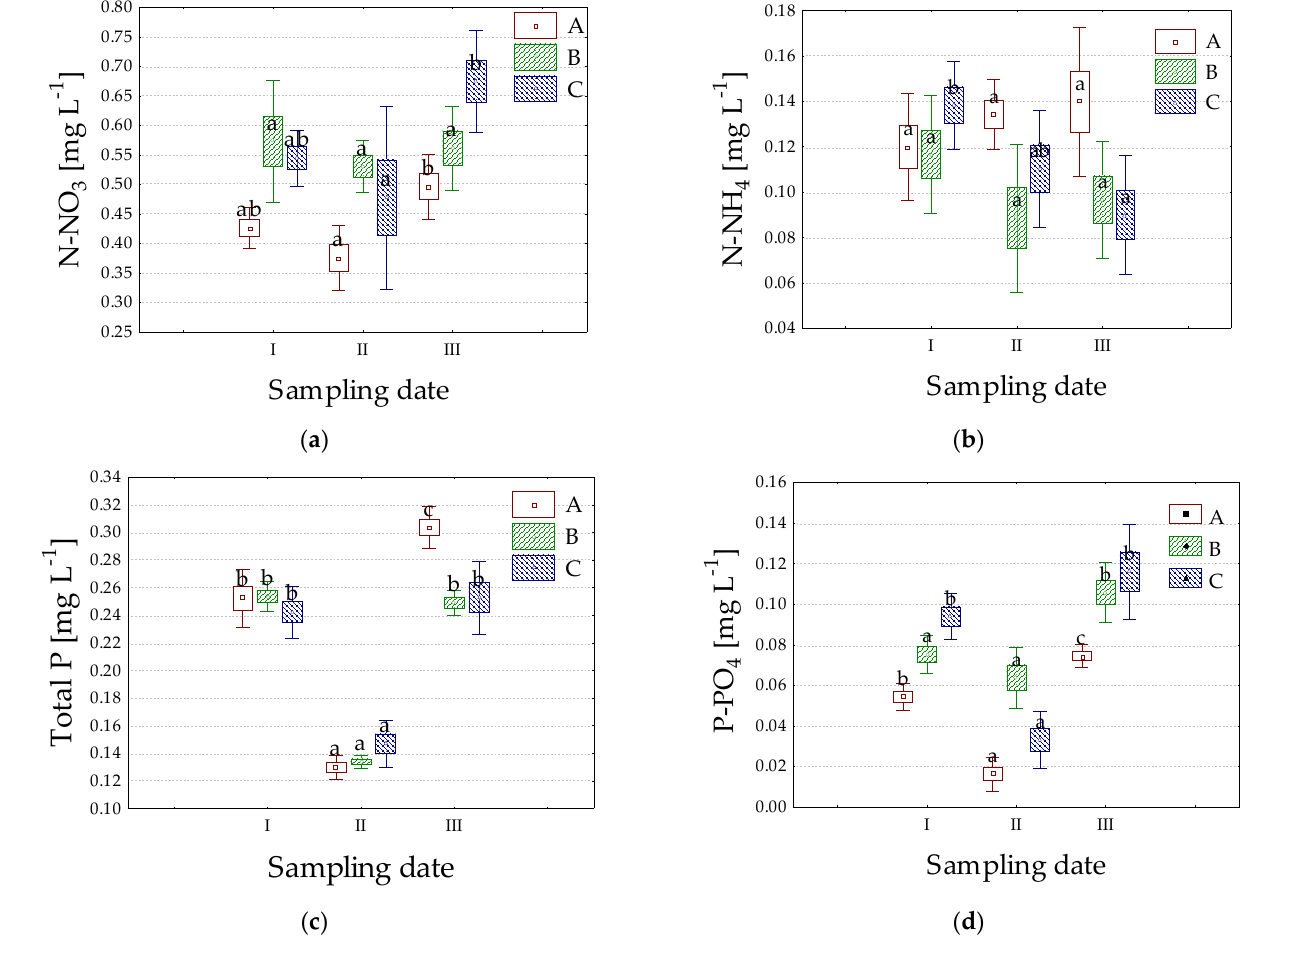
Figure 4. Changes in concentration of ( a ) NO 3 -N, ( b ) NH 4 -N, ( c ) total phosphorus, and ( d ) PO 4 -P in water samples in successive dates of sampling in three measurement points (A, B, C). Different letters (a, b, c) indicate statistically significant differences among sampling dates.